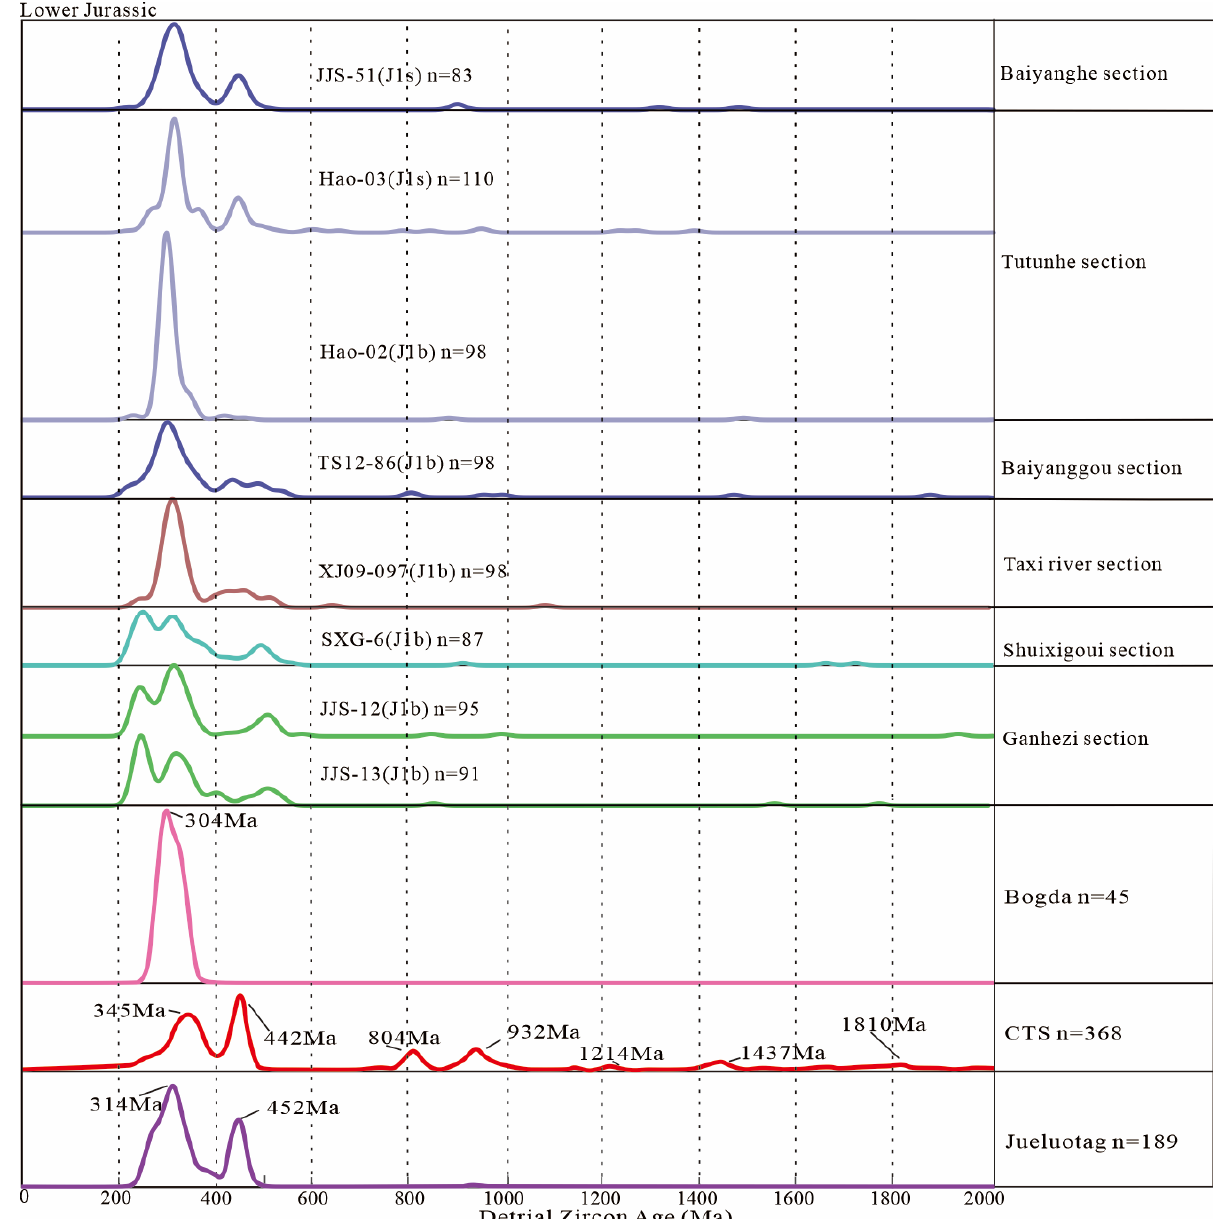
Figure 5. Relative probability map of U-Pb ages of Early Jurassic detrital zircons (data from [23,25,33,35,63]); for map locations, see Figures 1c and 3. Age spectra of potential-source-area features (data from [64,65,68,74] and references therein).